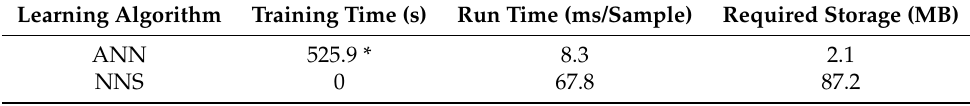
Table 4. Computation times (for a training database N = 124,214) for both ANN and NNS